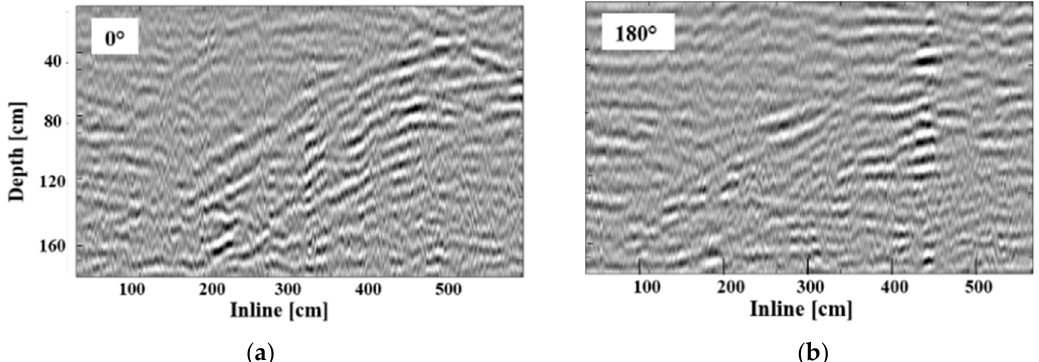
Figure 9. Highlights on the boundary conditions: ( a ) 0 degrees, starting point; and ( b ) 180 degrees, reverse case.